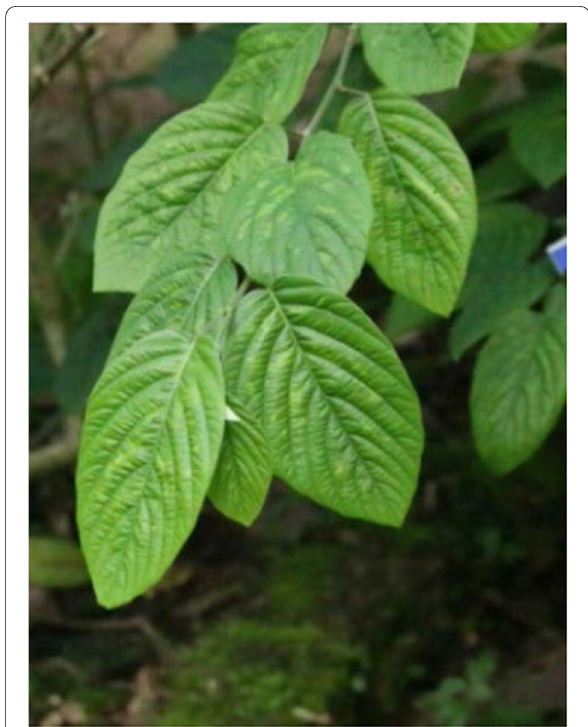
Fig. 1 Wild photograph of D. gangeticum (L.)